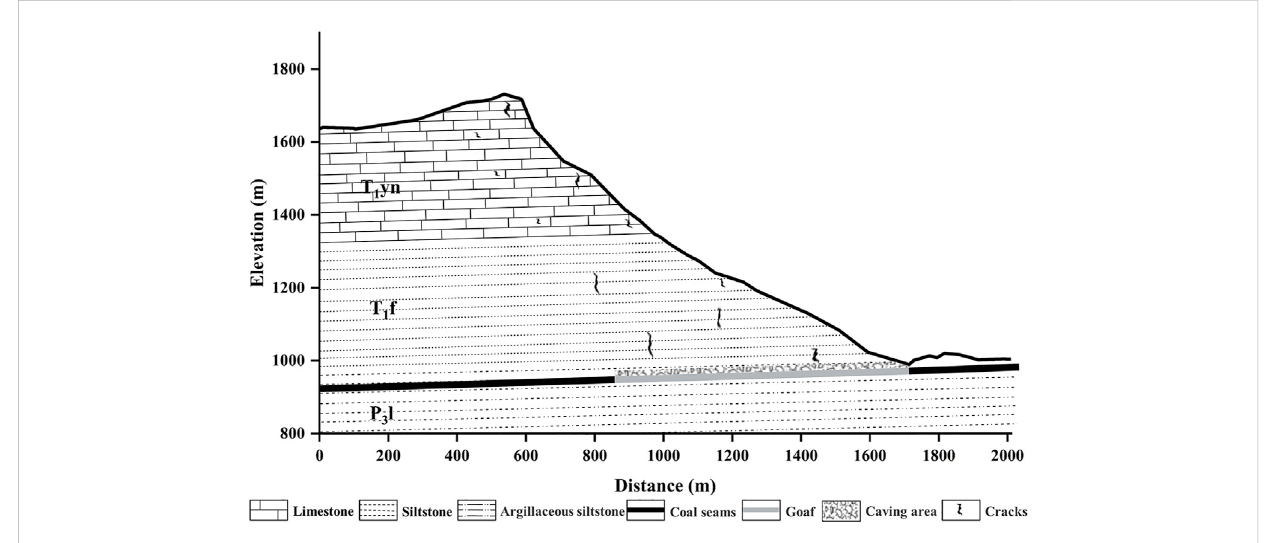
FIGURE 3 Geological settings along pro fi le AA ’ of the Pingdi landslide, the location of AA ’ is marked in Figure